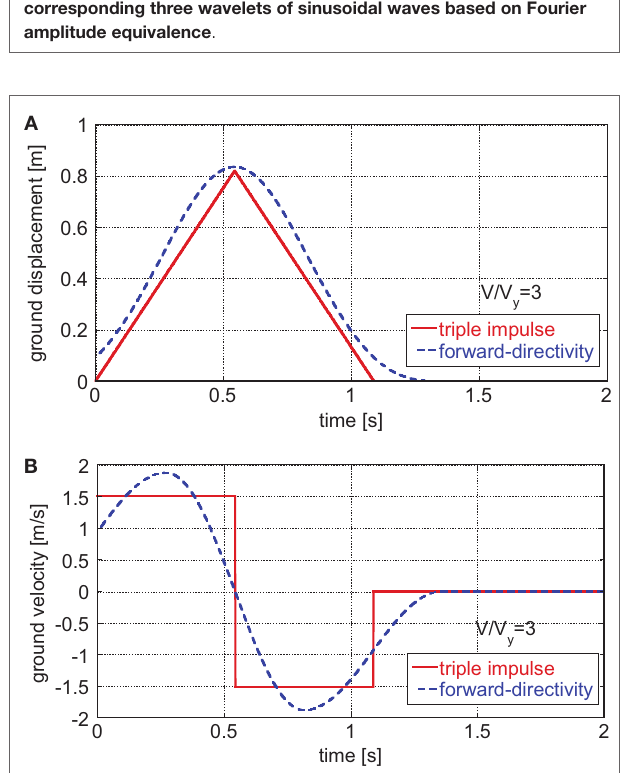
FigUre 9 | comparison of ground displacement and velocity between triple impulse and the corresponding three wavelets of sinusoidal waves: (a) displacement, (B) velocity .